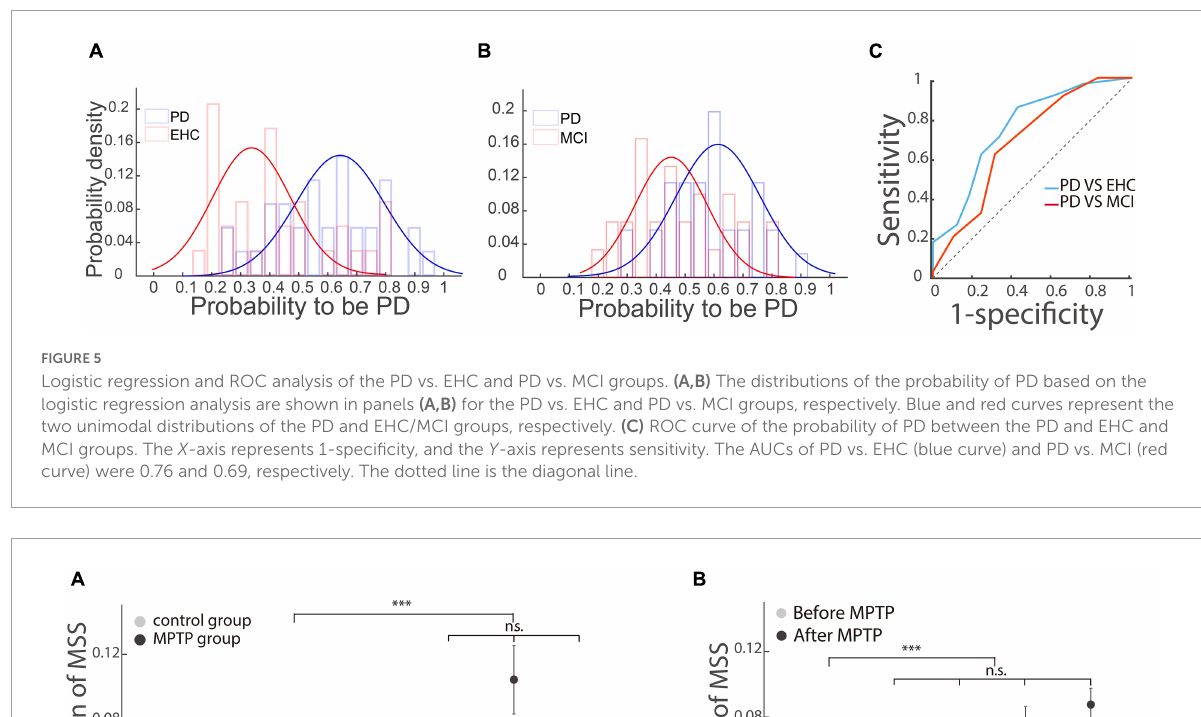
is different between ipsilesional and contralesional